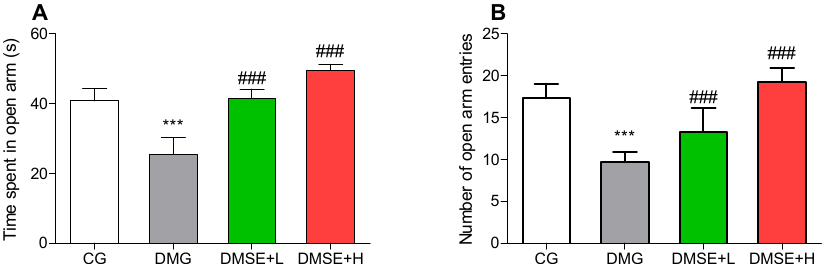
Figure 3. Effect of MSE on the anxiety-like behavior ( A ) time spent in the open arm and ( B ) number